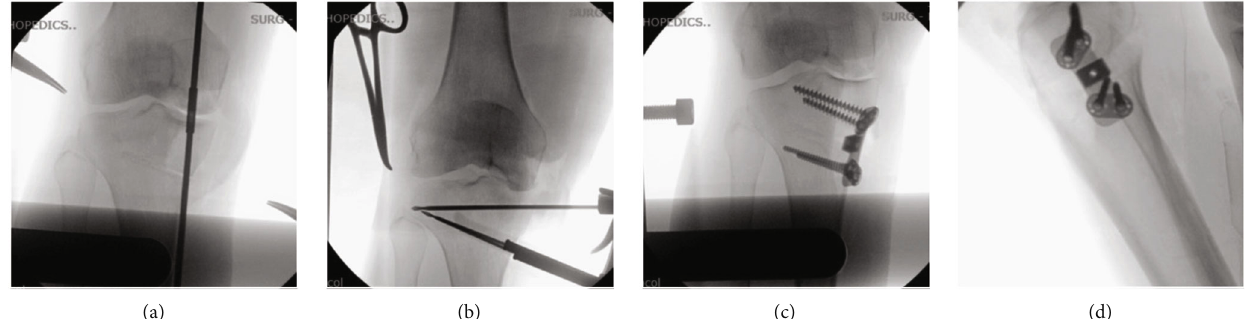
Figure 7: High tibial osteotomy X-rays. (a) Intra-operative mechanical axis. (b) Alignment HTO guide. (c) HTO fi xation anterior view. (d) HTO fi xation lateral view.